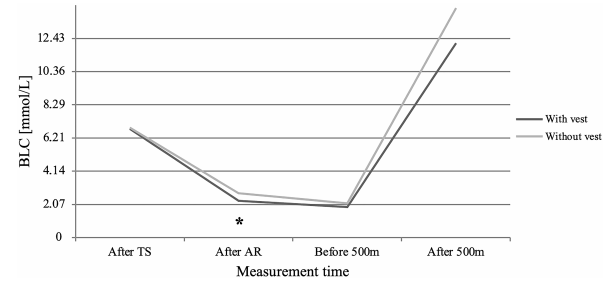
Fig. 4. Blood lactate concentration along the protocol for both AR conditions, with and without wearing the cooling vest. The asterisk indicates that there was a significant difference ( p < 0.05), for the respective measurement time point. BLC, blood lactate concentration; TS, training session; AR, active recovery.